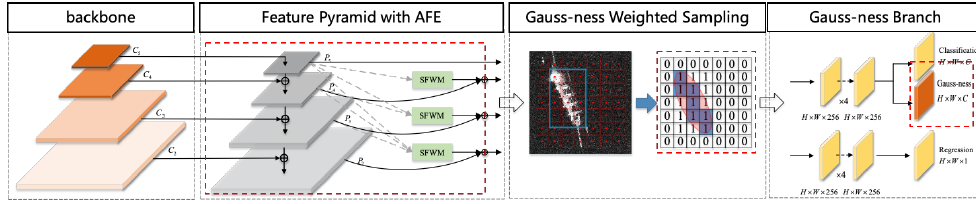
Figure 3. The overall framework of the proposed algorithm for ship target in SAR